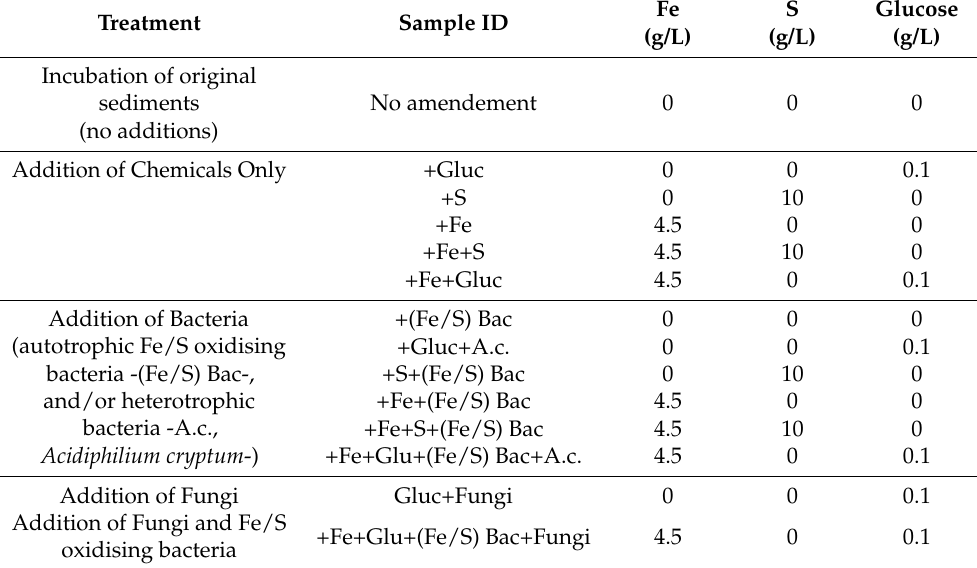
Description of the different combinations of chemical and microbial amendments performed in this study. Reported are also the final concentrations for the chemical amend-